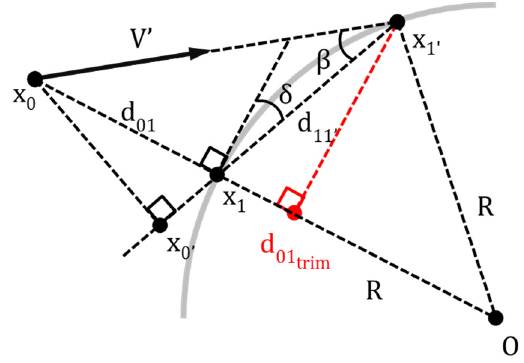
Figure 7. System geometry for a circular path.